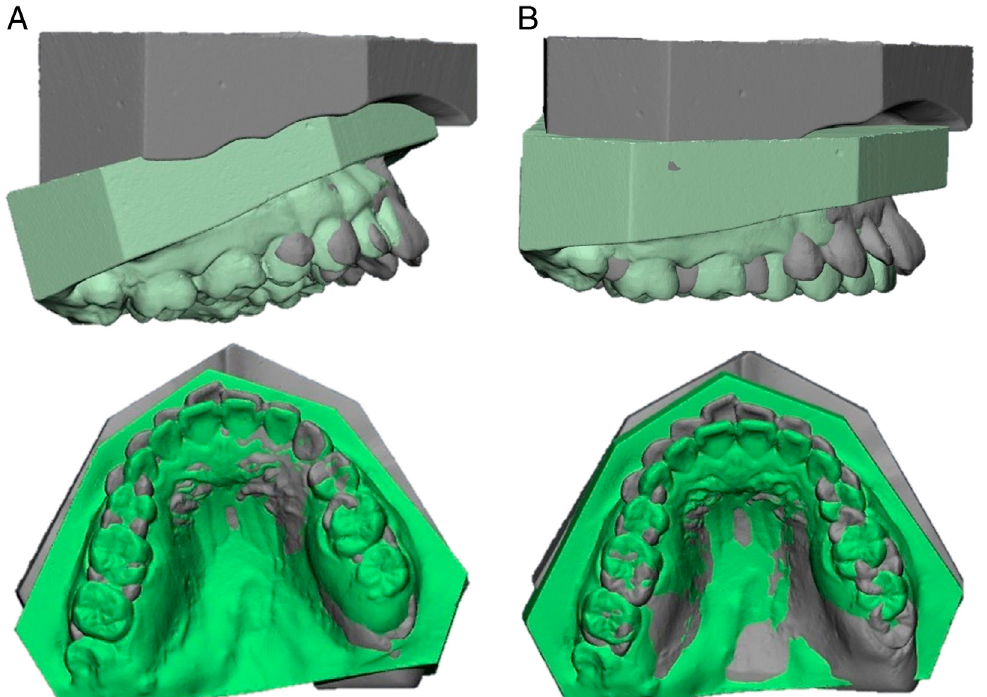
Figure 1. Superimposition of the 3D study casts from lateral (above) and palatal (below) views. (a) Casts that were aligned using points on the anterior segment only, which comprised the medial two-third of the third palatal rugae, showed inconsistencies in the superimposition due to lack of pitch control. (b) Alignment of the casts using the tripoding method showed more consistent